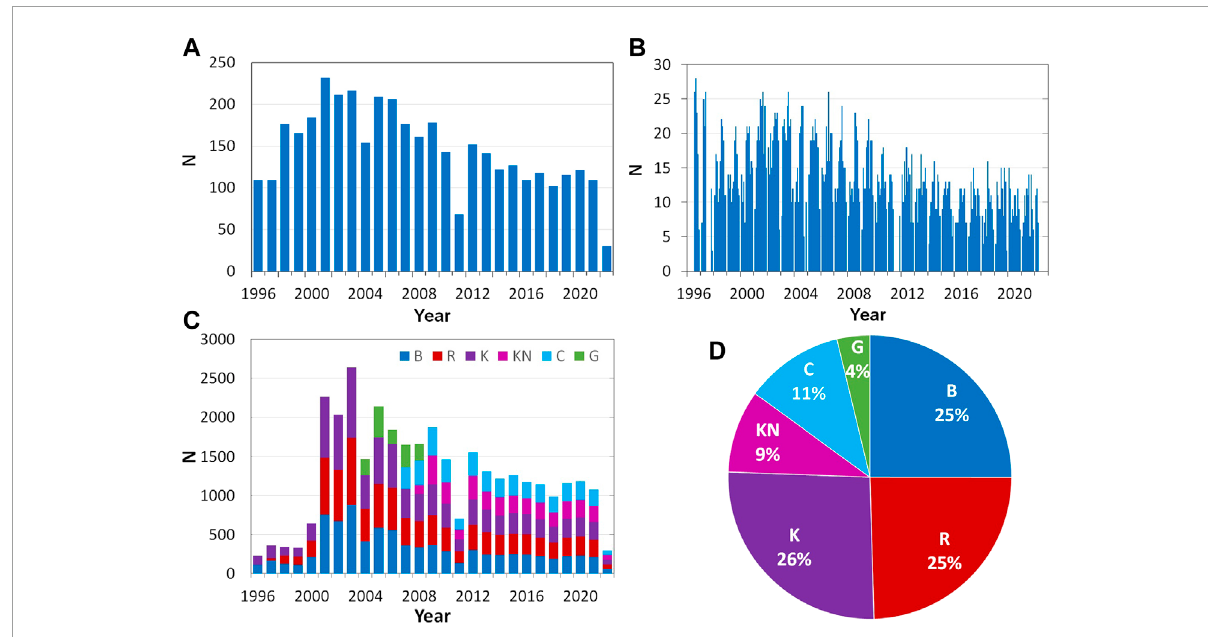
FIGURE 11 (A,B) Number (N) of observing days per year (A) and month (B) from 1996 to 2022. (C,D) Number (N) of Rome/PSPT observations at the diverse spectral bands obtained per year from 1996 to 2022 (C) and statistics of the data available at the diverse observed bands (D)